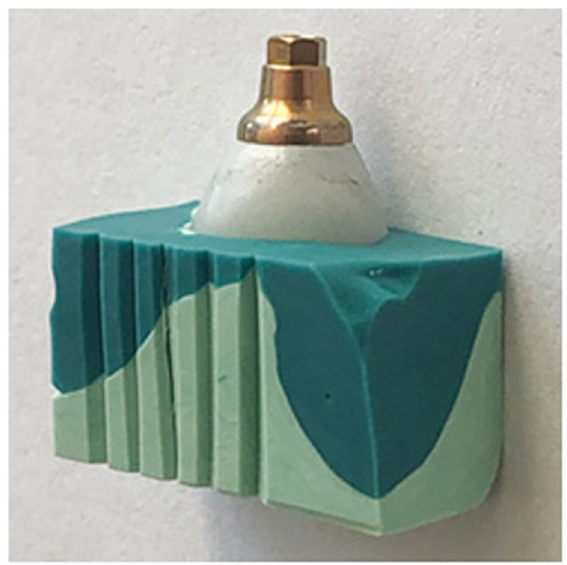
Fig. 6 Putty mold with specimen. Putty (light green) and a-silicone impression material (dark green).